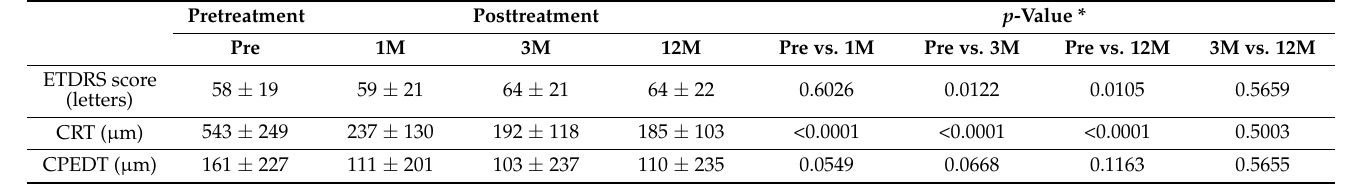
Table 1. Pre- and Post-Treatment ETDRS Scores and Central Retina